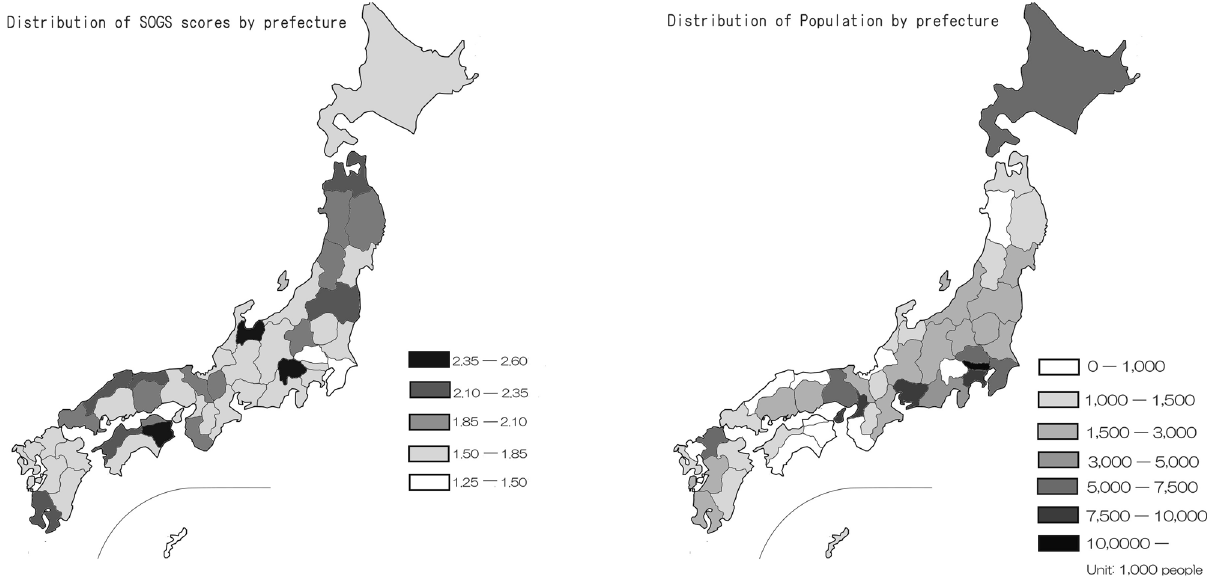
Figure 3. SOGS and population distributions (made using Zoner Photo Studio 18 (Ver. 0.19) https:// www. zoner.